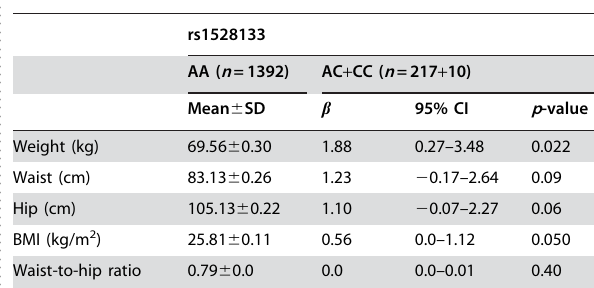
Table 2. Anthropometrical characteristics of 1680 women from the EPIC study by genotype for rs1528133 SNP in